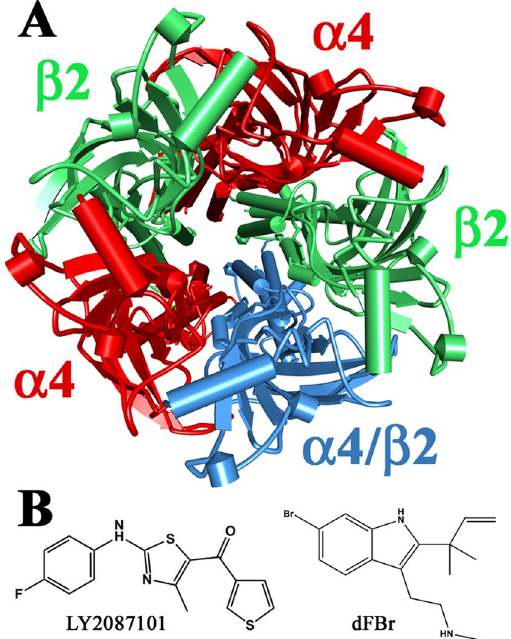
Figure 1. Top views depicting α 4 β 2 nAChR based on the X-ray structure of human ( α 4)2( β 2)3 nAChR (PDB: 5KXI) and the chemical structures of LY2087101 and